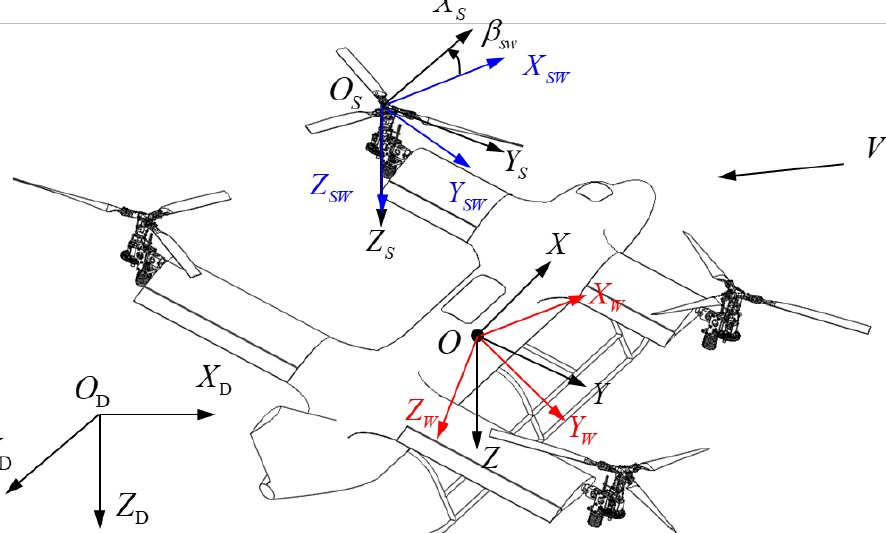
Table 1. General parameters of the quad tiltrotor.